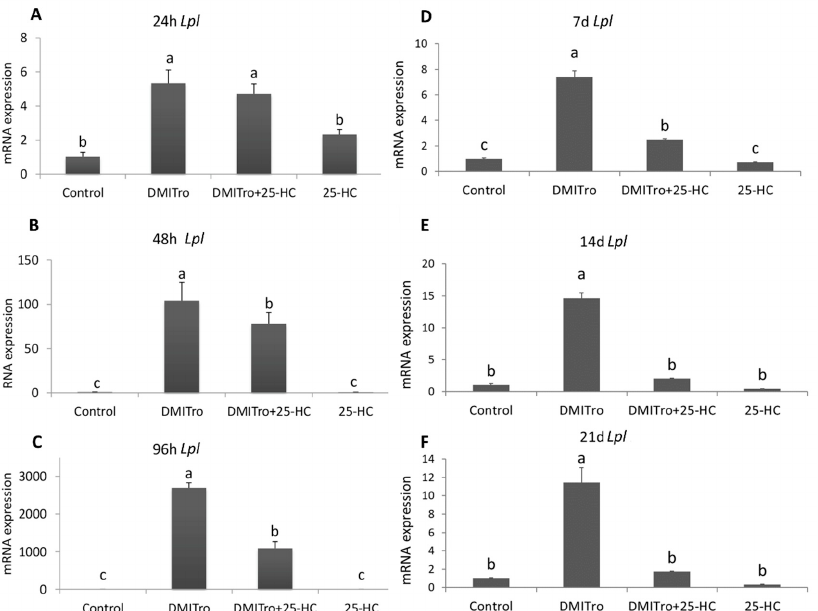
Figure 6. The effects of 25-HC on the expression of Lpl mRNA at different time points: ( A ) 24 hours, ( B ) 48 hours, ( C ) 96 hours, ( D ) 7 days, ( E ) 14 days, ( F ) 21 days. C3H10T1 / 2 cells at confluence were treated with a control, DMITro (500 nM DEX, 0.5 mM IBMX, 20 µ g / mL Insulin and 10 µ M Tro), DMITro + 10 µ M 25-HC or 25-HC alone for 24 h, 48 h, 96 h, 7 days (d), 14 days and 21 days. The results show the average values of three replicates ( n = 3) and the SD of the means. Bars with the same letter are not significantly different.